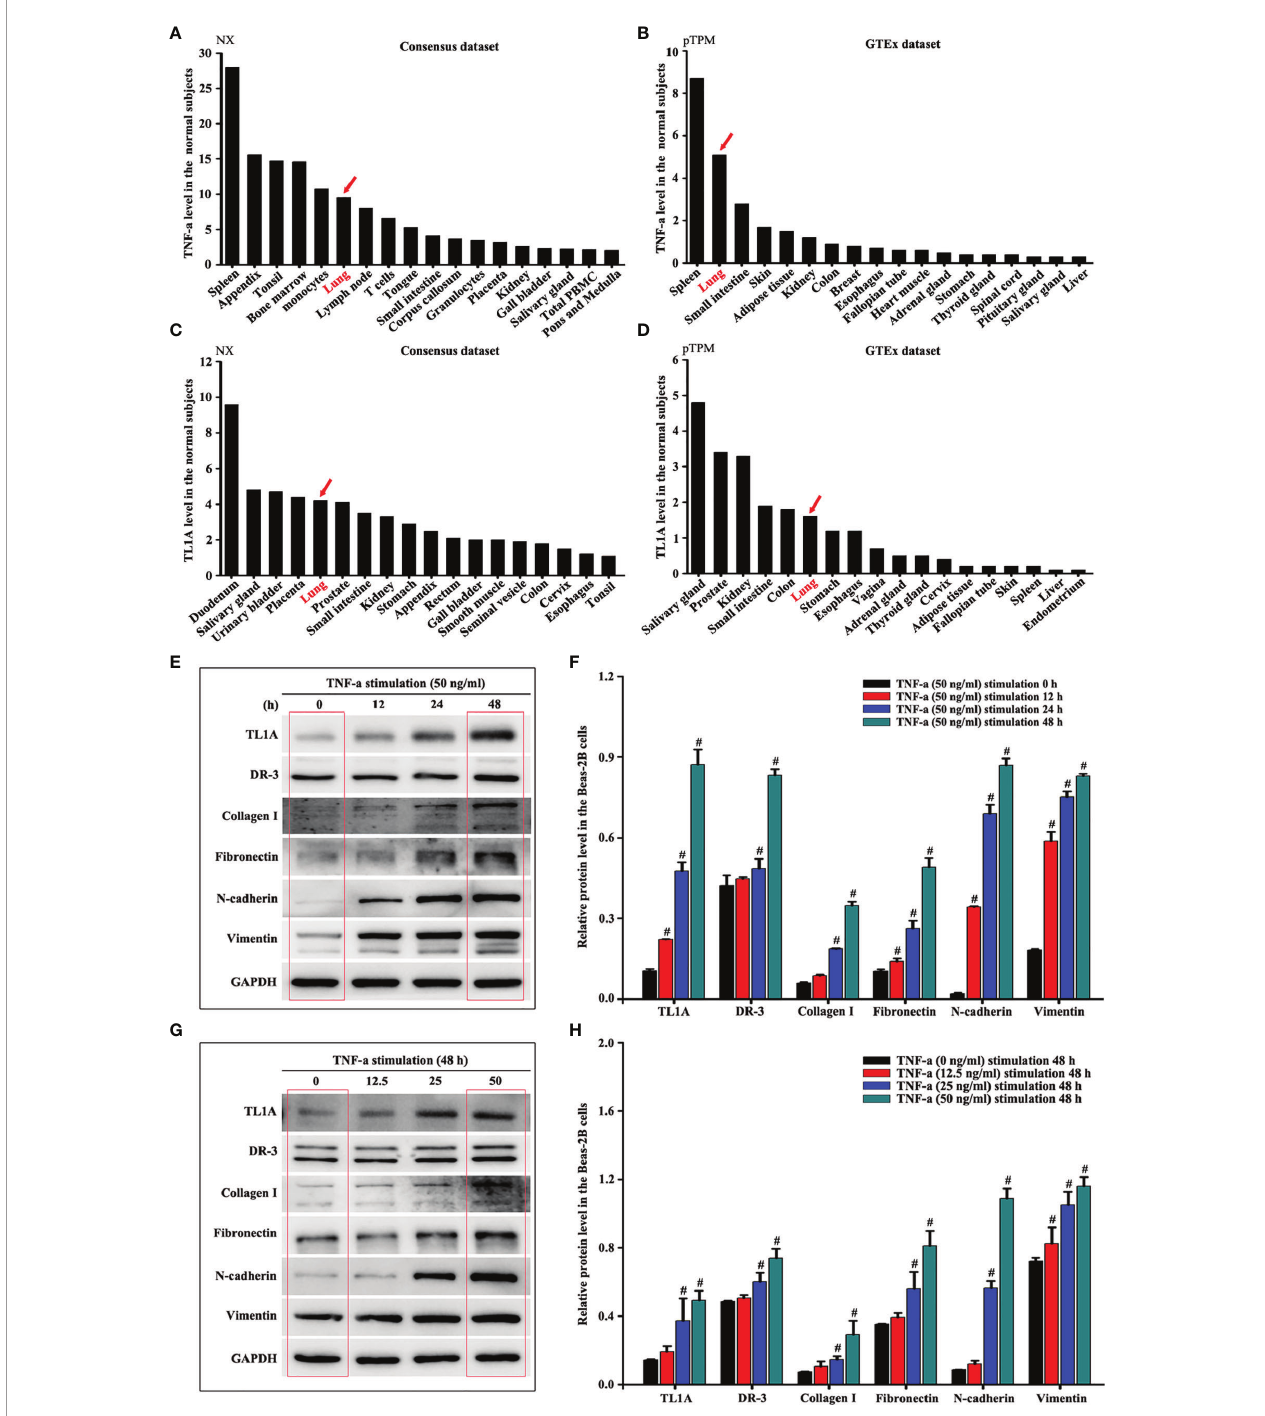
FIGURE 7 | Human Tissue Atlas (http://www.proteinatlas.org/) was used to identify the protein levels of TNF-a (A, B) and TL1A (C, D) . The same concentration of TNF-a stimulated Beas-2B cells at different times (E) or different concentrations of TNF-a stimulated Beas-2B cells at the same time (G) to evaluate the effects of TNF-a on TL1A, DR3, collagen I, fi bronectin, vimentin, and GAPDH by Western blotting analysis. (F, H) intensity analysis of (E, G) . Data are shown as the means ± SD for three independent experiments. # p < 0.05 versus the control